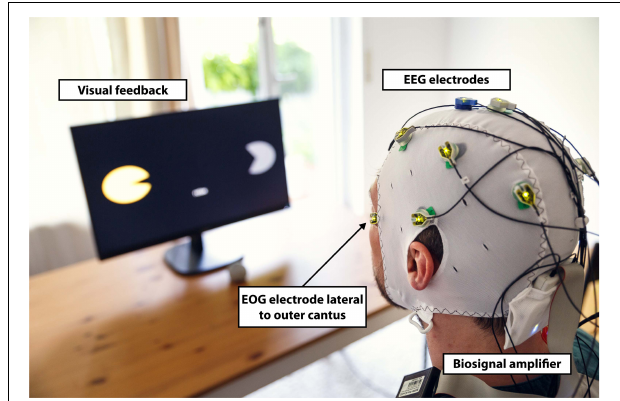
FIGURE 3 | Short horizontal oculoversions (HOVs) vs. prolonged HOVs (figure shows only curve shape in positive direction resulting from left eye movements; curve shapes in negative direction from right eye movements are not visualized). Gray curve shapes show single trials; bold blue lines show average HOVs. Comparisons reveal distinct time difference between short HOV ( < 1 s) and prolonged HOV ( > 1 s, with its characteristic rectangular curve shape). The thin blue line indicates the 70% detection